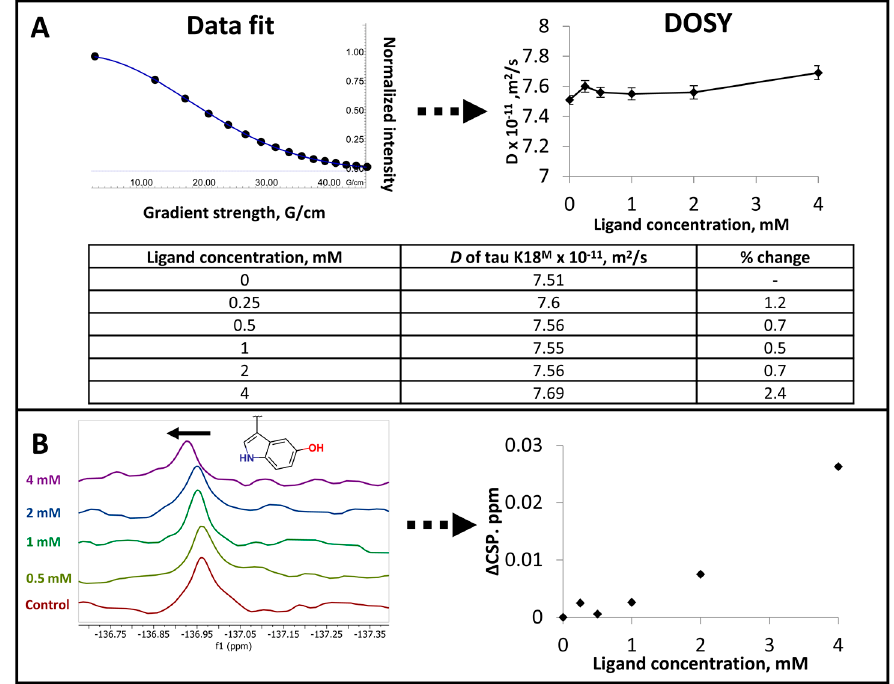
Figure 4. Investigating tau K18 M and Cl-NQTrp interactions using diffusion-ordered spectroscopy (DOSY) and 19 F NMR. ( A ) The determination of diffusion rate D for 50 µM tau K18 M in the presence of different concentrations of compound 6C. ( B ) 19 F NMR spectra for 50 µM tau K18 M (3-fluoro-Y310) and the observed chemical shift perturbations (CSPs) in the presence of compound 6D. Black arrow denote the vector direction of CSPs.